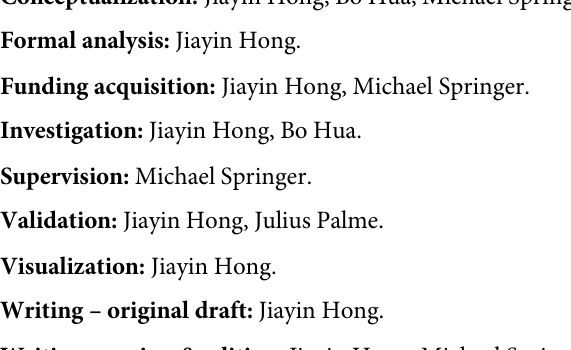
S1 Table. List of strains used in this study. S2 Table. Parameter descriptions, units, and ‘best-fit’